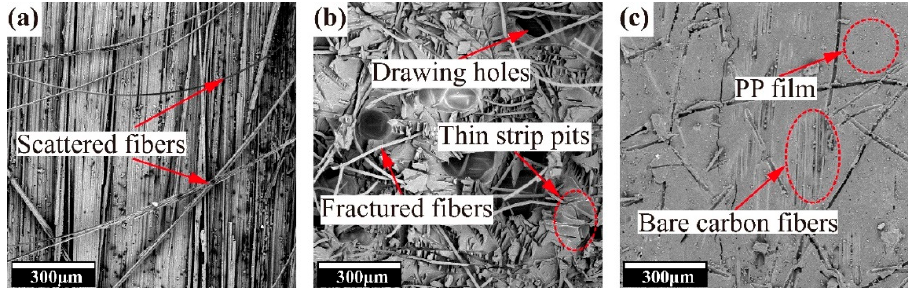
Figure 2. SEM images of delaminated surfaces of composites after DCB testing. ( a ) Non-toughened composite, ( b ) 10 PI-toughened composite, ( c ) 10 PP-toughened composite.